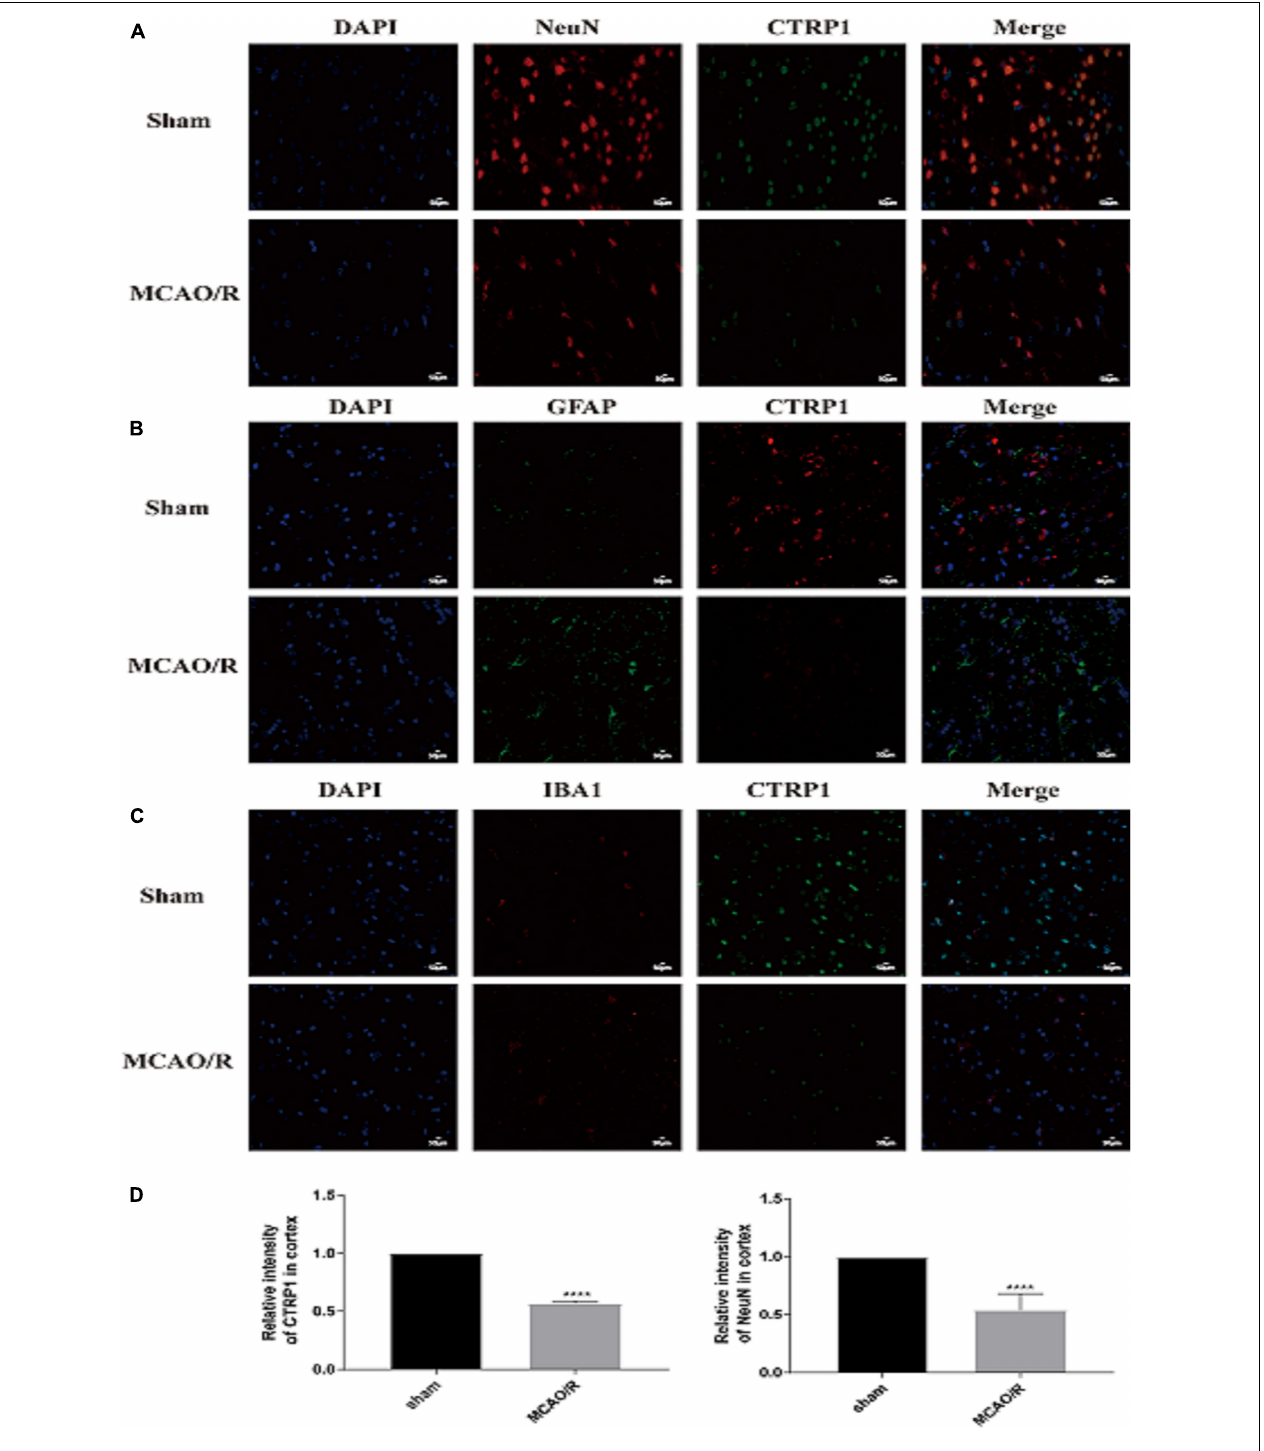
FIGURE 2 | The location and expression of CTRP1 in the brain analyzed by immunofluorescence ( n = 3). (A) The expression of CTRP1 in neuron in the cortex, NeuN was used to label neuron. CTRP1 expression was observed by fluorescence microscope and is shown by green fluorescence. NeuN expression is shown by red fluorescence. The nuclei were stained with DAPI and is shown by blue fluorescence. (B) The expression of CTRP1 in astroglia in the cortex. GFAP was used to label astroglia. CTRP1 expression is shown by red fluorescence. GFAP expression is shown by green fluorescence. (C) The expression of CTRP1 in microglia in the cortex. IBA1 was used to label microglia. CTRP1 expression is shown by green fluorescence. IBA1 expression is shown by red fluorescence. (D) The intensity of CTRP1 and NeuN in the cortex. The representative images were acquired under × 400 magnification, scale bars = 50 µ m. **** p < 0.0001 vs. sham group.